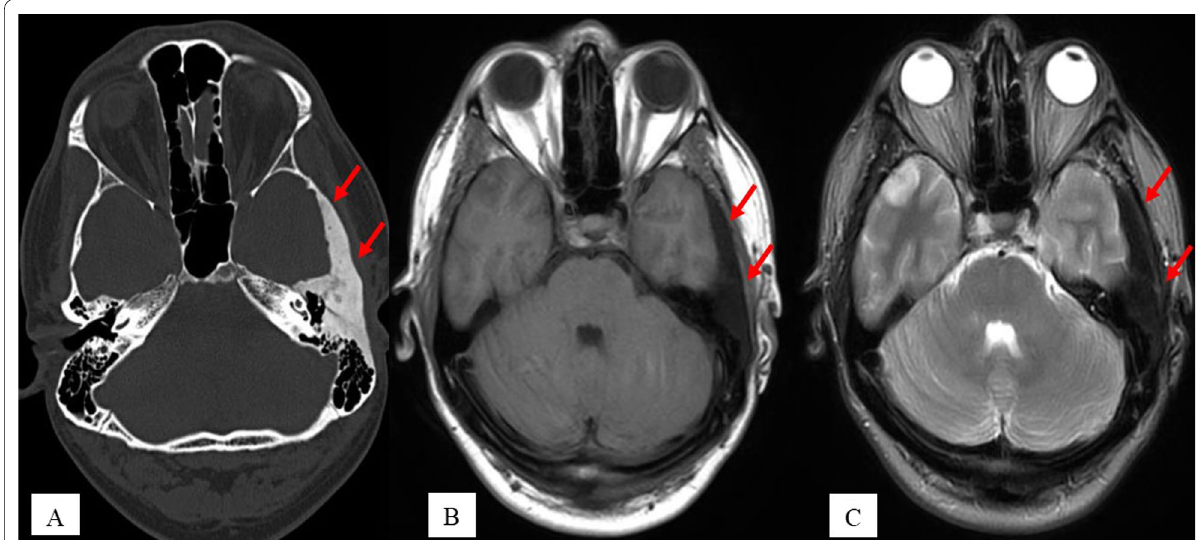
Fig. 3 Determination of nature of lesion by CT and MRI in a 25 year old male ( A ) CT bone algorithm image shows well defined expansile sclerotic lesion giving ground glass appearance involving squamous and mastoid part of left temporal bone. MRI shows expansile sclerotic lesion involving squamous and mastoid part of left temporal bone appearing hypointense on both T1W ( B ) and T2W ( C ) images. This was a case of fibrous dysplasia. Both CT and MRI were able to classify the nature of the lesion to be sclerotic in this